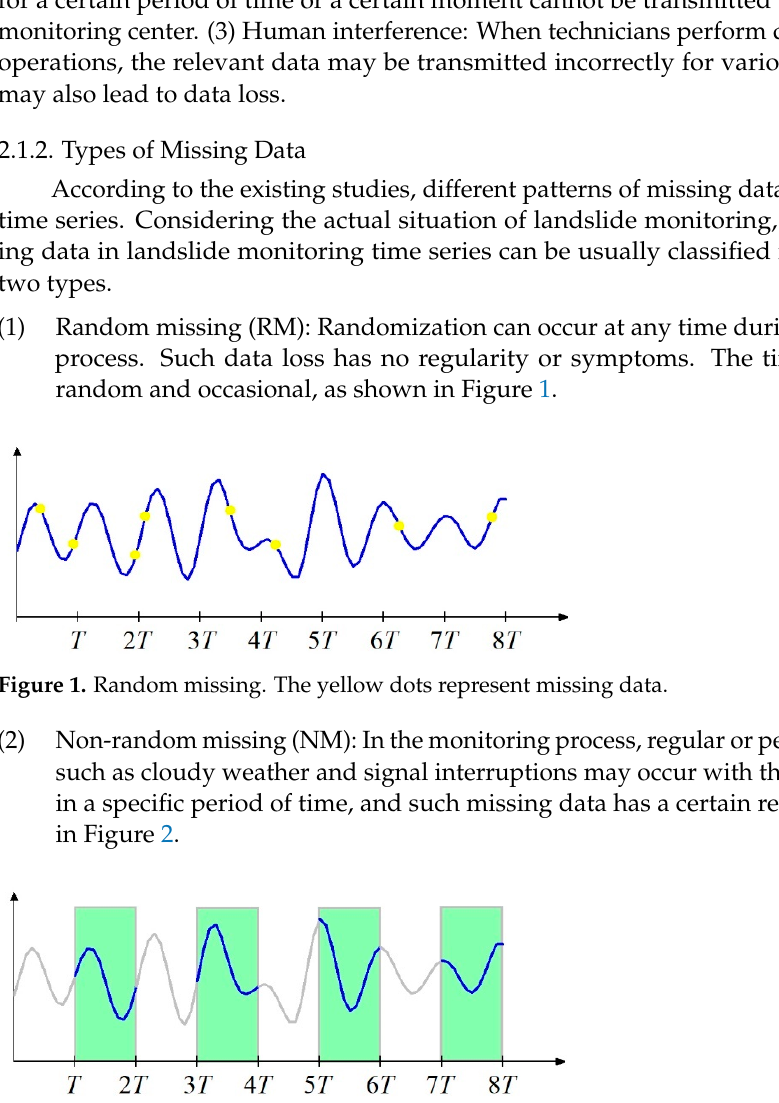
Figure 2. Non-random missing. The curves in the green area represent missing data.